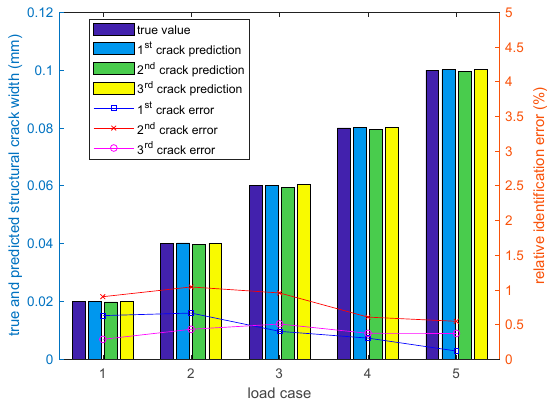
Figure 15. Comparison of the true and predicted crack widths.